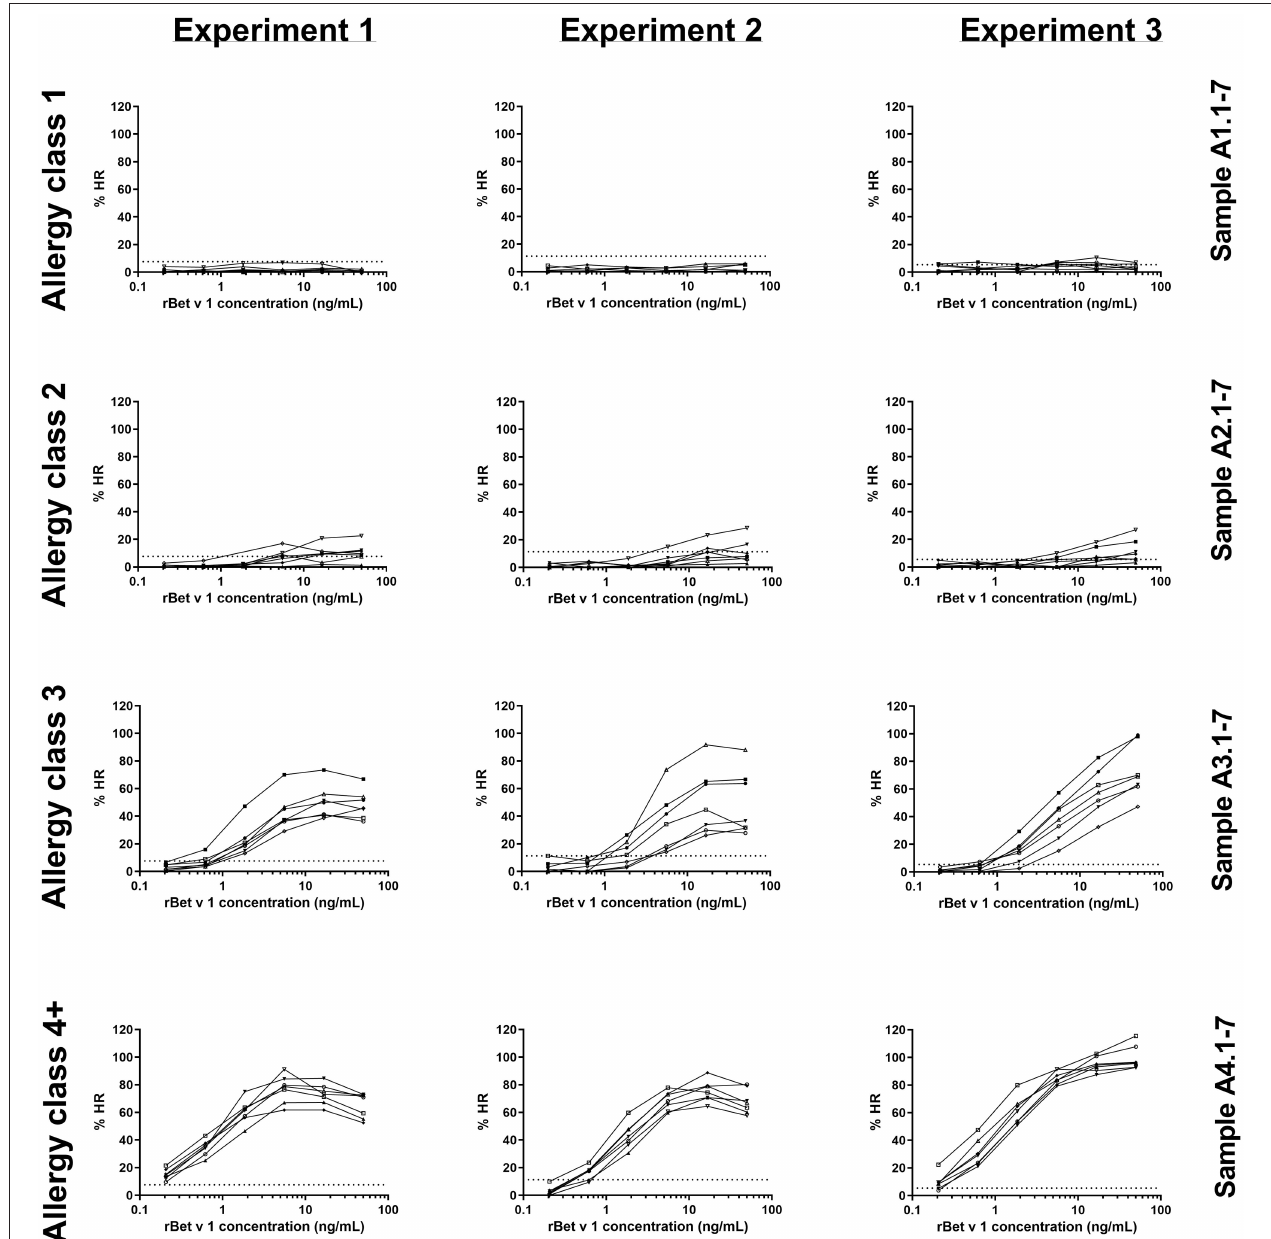
FIGURE 1 | rBet v 1-induced histamine release (HR) curves for 28 sera in experiments 1, 2, and 3. Histamine release is expressed as %HR of the PMA/ionomycin response. Sera are shown in their respective allergy class and each experiment represents a cell donor. Numbers refer to sample ID ( Table 1 ). Dotted horizontal lines indicate background values obtained from the negative control serum pool (8, 11, and 6% for experiments 1, 2, and 3,